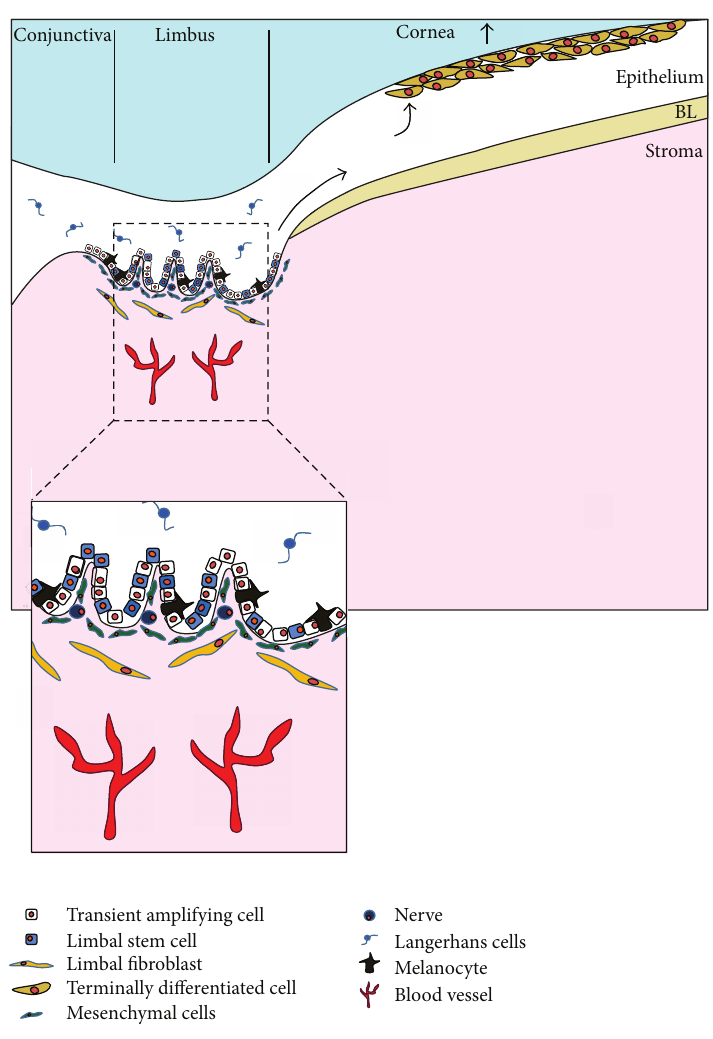
Figure 2: Limbal SCs for the corneal epithelium reside in the basal layer of the limbal epithelium. Transient amplifying cells divide and migrate towards the central cornea to replace the terminal corneal ECs that get shed from the corneal surface. The stroma of the limbal SC niche is populated by fibroblasts and nourished by blood vessels (BL: Bowman’s layer).